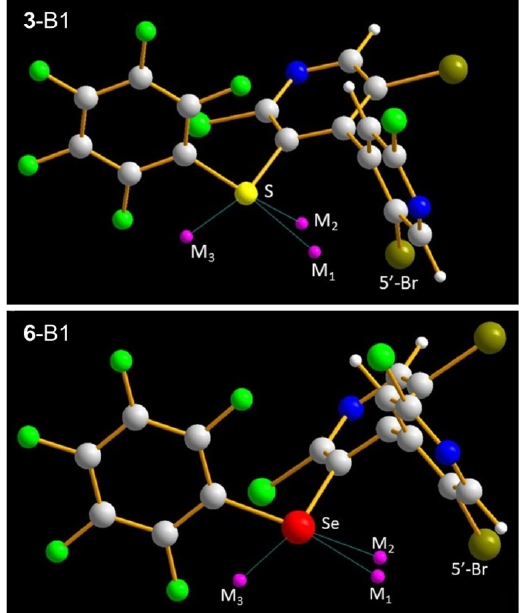
Figure 4. Calculated σ-holes on the elongation of C ArF –Ch (M1, M2) and C Pyr –Ch (M3) bonds in conformers 3 -B1 and 6 -B1. Tube structures colors: σ-holes (pink), bromine (dark green), carbon (grey), chlorine and fluorine (green), hydrogen (white), nitrogen (blue), selenium (red), sulfur (yellow). Pictures were obtained through the code Diamond v3.21. Putz, H. & Brandenburg, K. (1997–2012). Diamond—Crystal and Molecular Structure Visualization. Crystal Impact, GbR, Kreuzherrenstrasse 102, 53227 Bonn, Germany, http://www.crystalimpact.com/diamond. A different trend is observed for compounds 1 and 4 , likely due to the poor electron-attracting power of the methyl group. In particular, for 1 -A2 no σ-hole on the elongation of C Me –S bond was detectable on the 0.002 isosurface (Table 2). Analogously, no σ-hole was found in 2 -B2 on the elongation of C Ph –S bond. Table 3. V S,max (au) and geometrical parameters of σ-holes (M) located on the elongation of C ArF –Ch bond in 3 -B1, 3 -B2, 6 -B1, and 6 -B2.